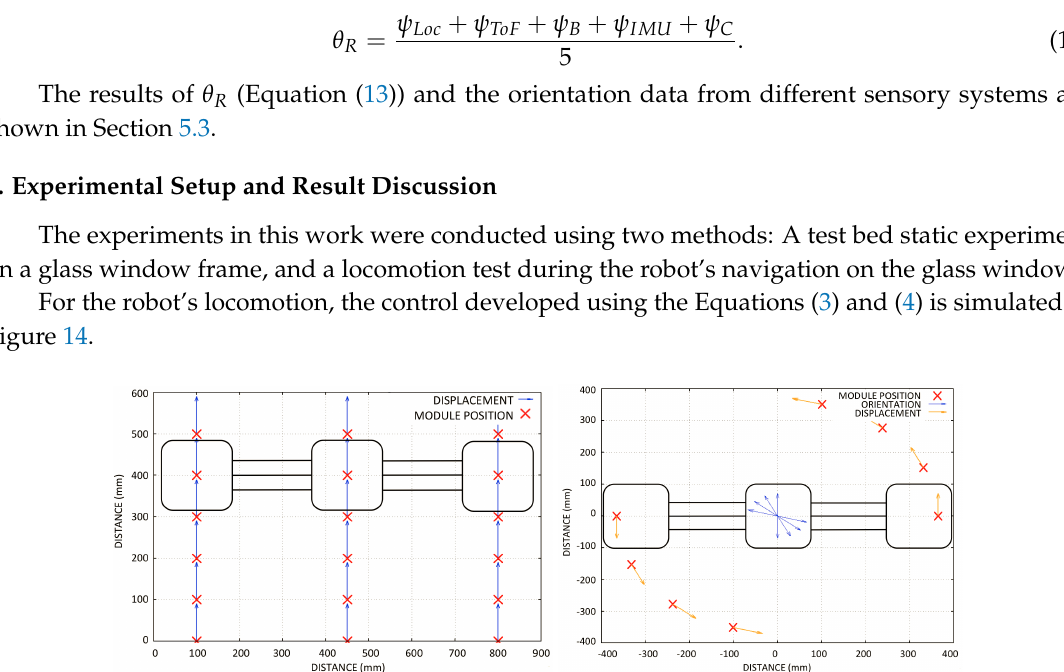
Figure 14. Mantis ’s locomotion simulation: In the left panel, climbing the window; in the right panel, rotation of the robot; the red x shows the position of each